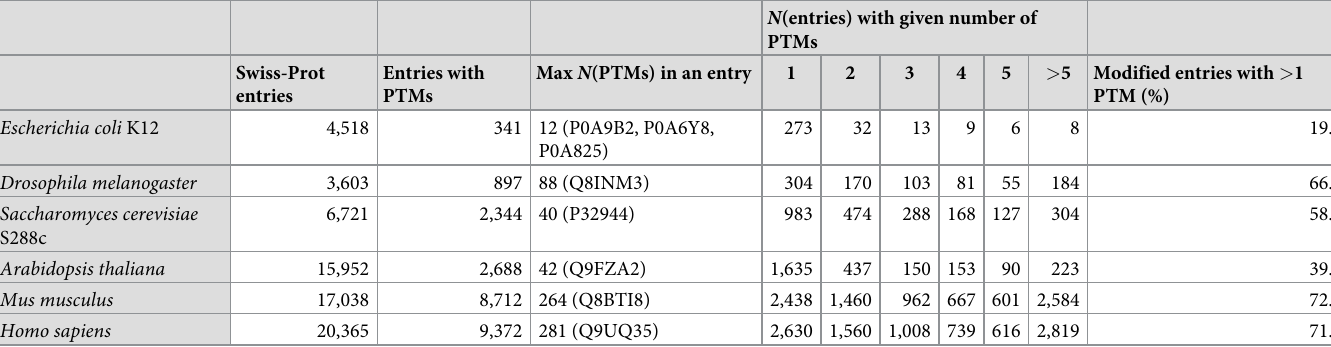
Table 1. Overview of the PTMs count in the Swiss-Prot entries for human and model organisms. [18].